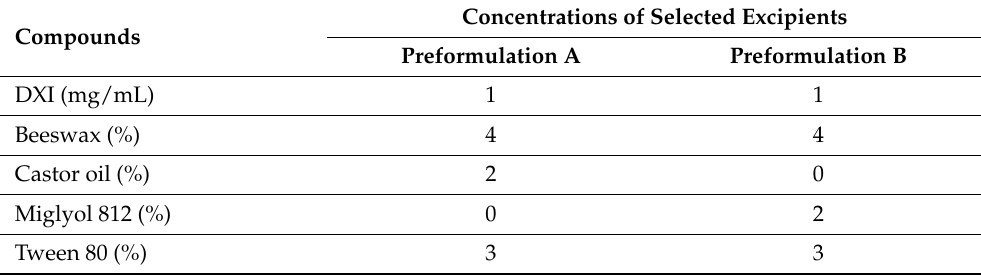
Table 1. Concentrations corresponding to the preformulation studies of NLCs encapsulating DXI. Concentrations of Selected Excipients Compounds Preformulation A Preformulation B DXI (mg/mL) 1 1 Beeswax (%) 4 4 2 0